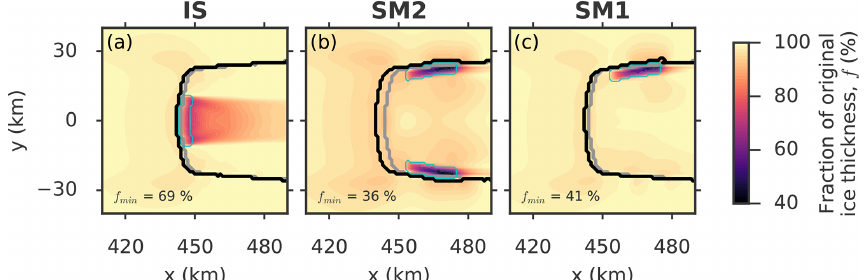
Figure 5. Fraction of initial ice thickness f (colorbar) in the vicinity of the grounding line at the end of the 100 year perturbation for the three different perturbation types and an applied melt-strip width of w = 4km. In each panel the minimum value of f is given in the lower left corner. Thick contours represent the grounding-line position in the initial state (gray) and in the perturbed states (black). The thin cyan contour denotes the perturbation area. Note that the total melt rate P is 2Gtyr − 1 in the IS and SM2 cases and 1Gtyr − 1 in the SM1 case for a better comparability between the SM1 and SM2 cases. The thinning pattern is shown for further time slices in Fig. S6 in the Supplement.